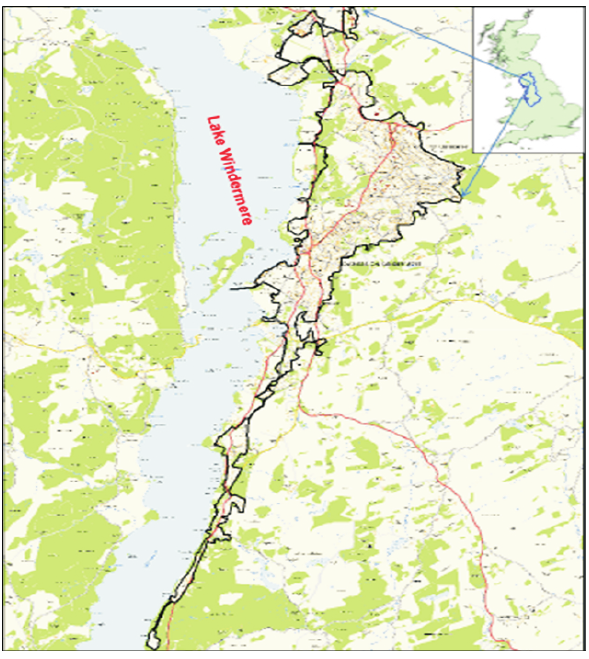
Figure 1: Location of Windermere in northwestern